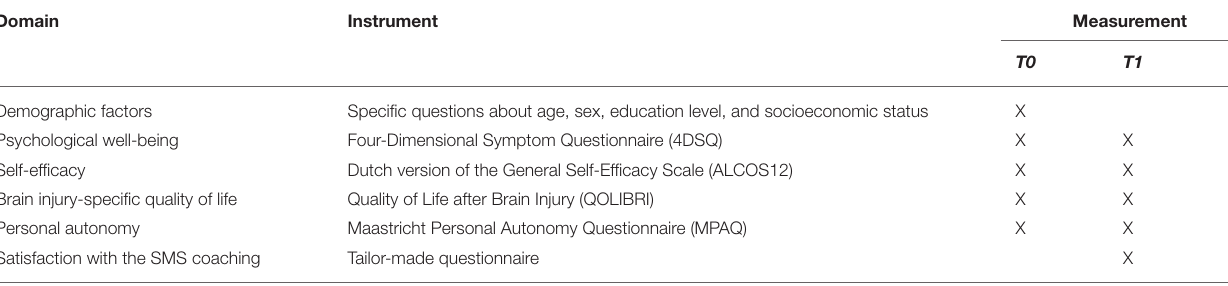
TABLE 2 | Patient outcome domains and questionnaires.